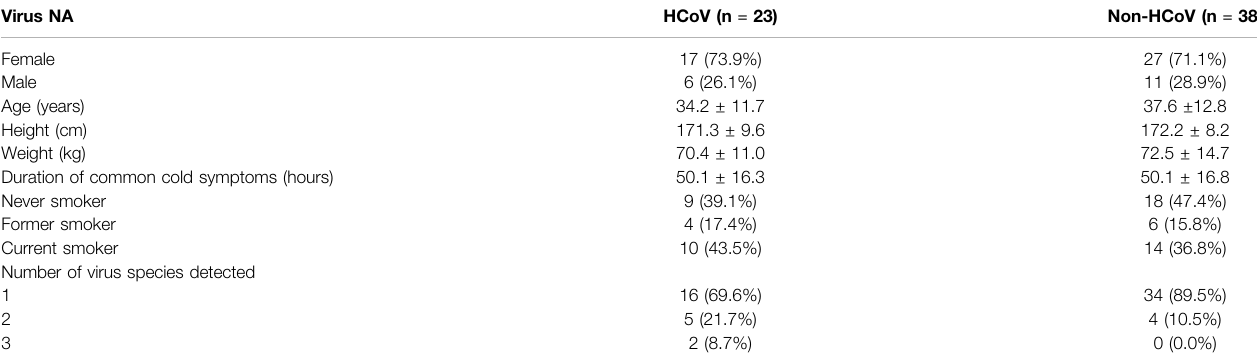
TABLE 1 | Baseline characteristics (number (%) of patients or mean ± SD, by HCoV detection). Virus